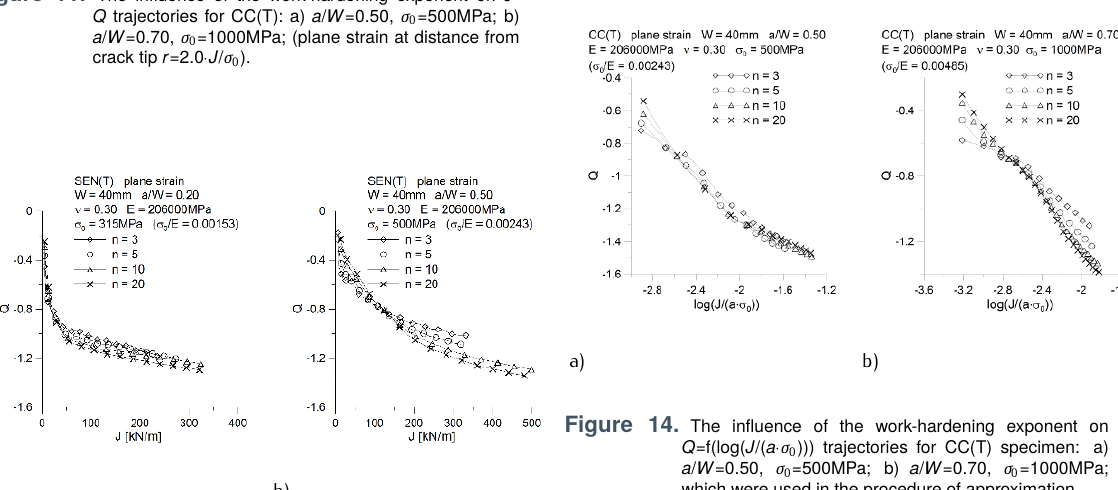
Figure 13. Theinfluenceoftheworkhardeningexponenton J - Q tra- jectoriesforSEN(T)specimenswithrelativecracklength a / W =0.70.